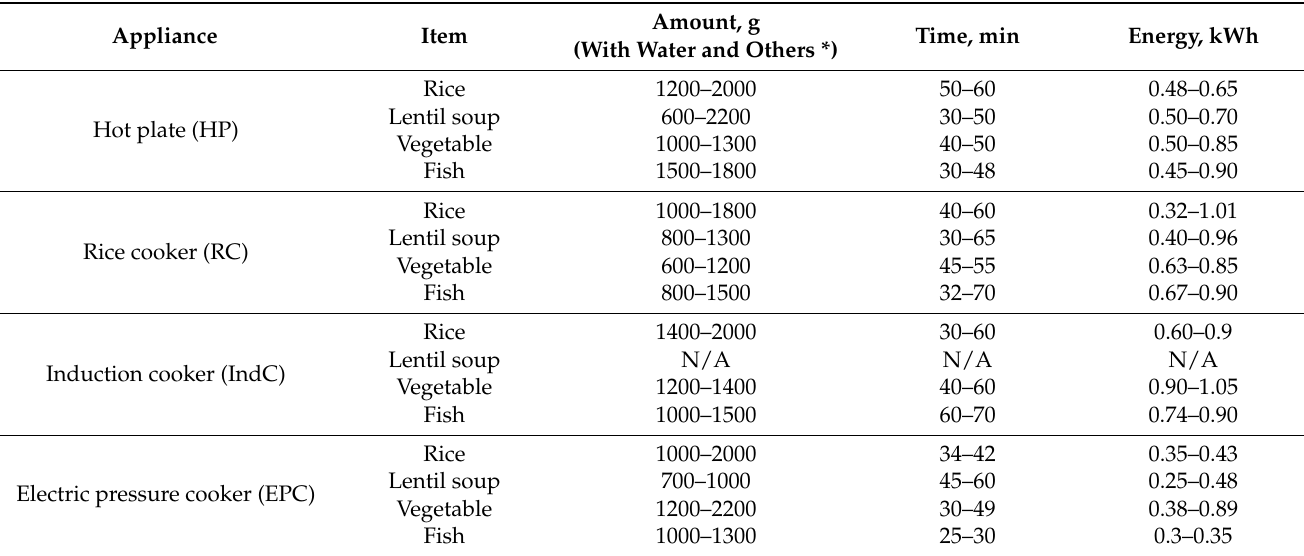
Table 2. Cooking data for different appliances.